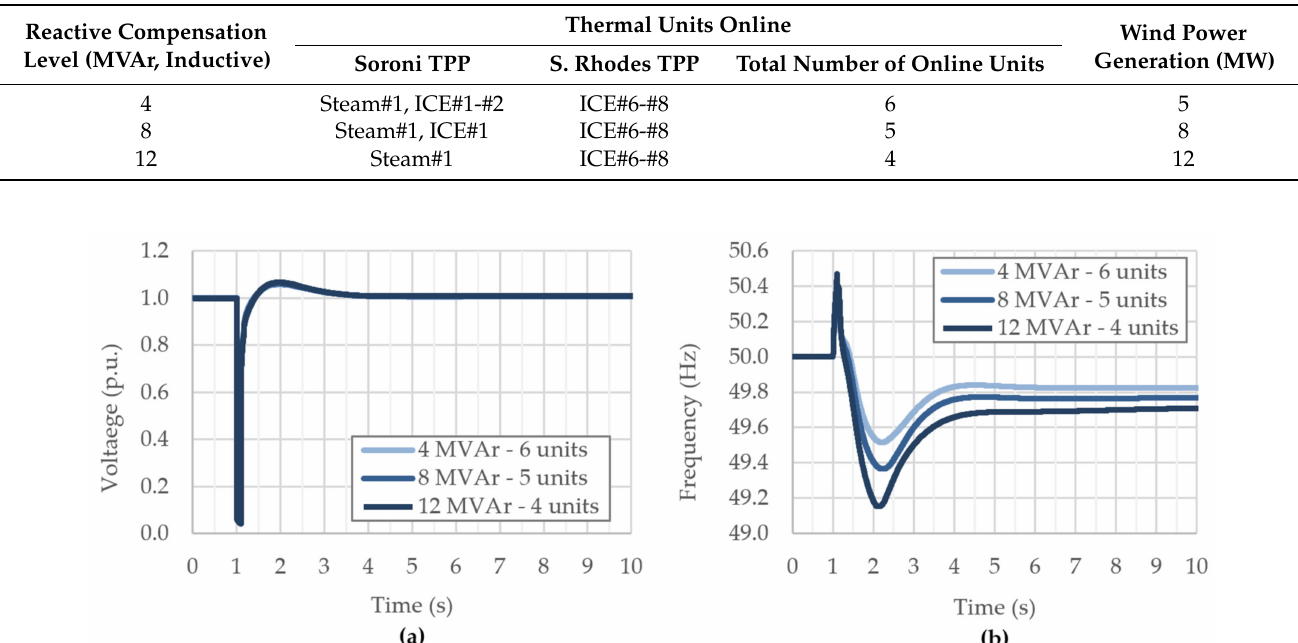
Figure 12. Simulated HV bus frequency at Soroni TPP for a single diesel unit trip. Table 2. UC-ED results at minimum load conditions for three reactive compensation levels.